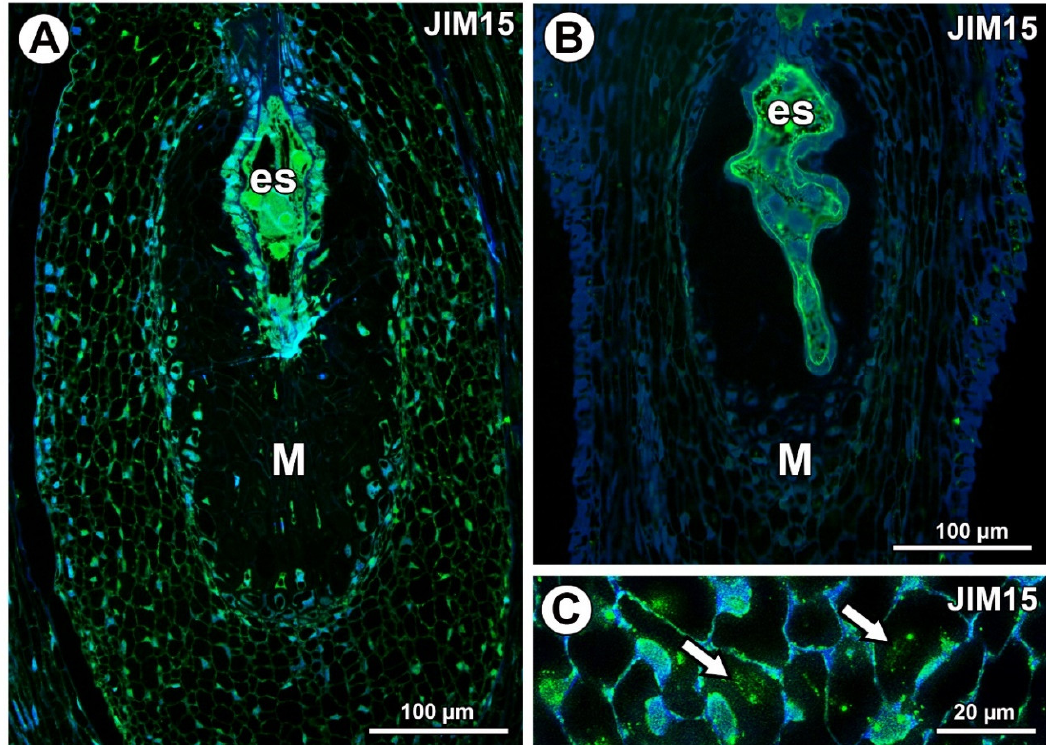
Figure 6. Arabinogalactan protein (labeled with JIM15) detection. ( A ) Section through the young Taraxacum seed; note the presence of embryo sac (es) and mucilage cells (M). ( B ) Section through the Pilosella officinarum ovule, with AGPs occurring in embryo sac; note the presence of mucilage cells (M). ( C ) Association between AGPs and calcium oxalate crystals (arrows) in ovule parenchyma cells of P. officinarum .